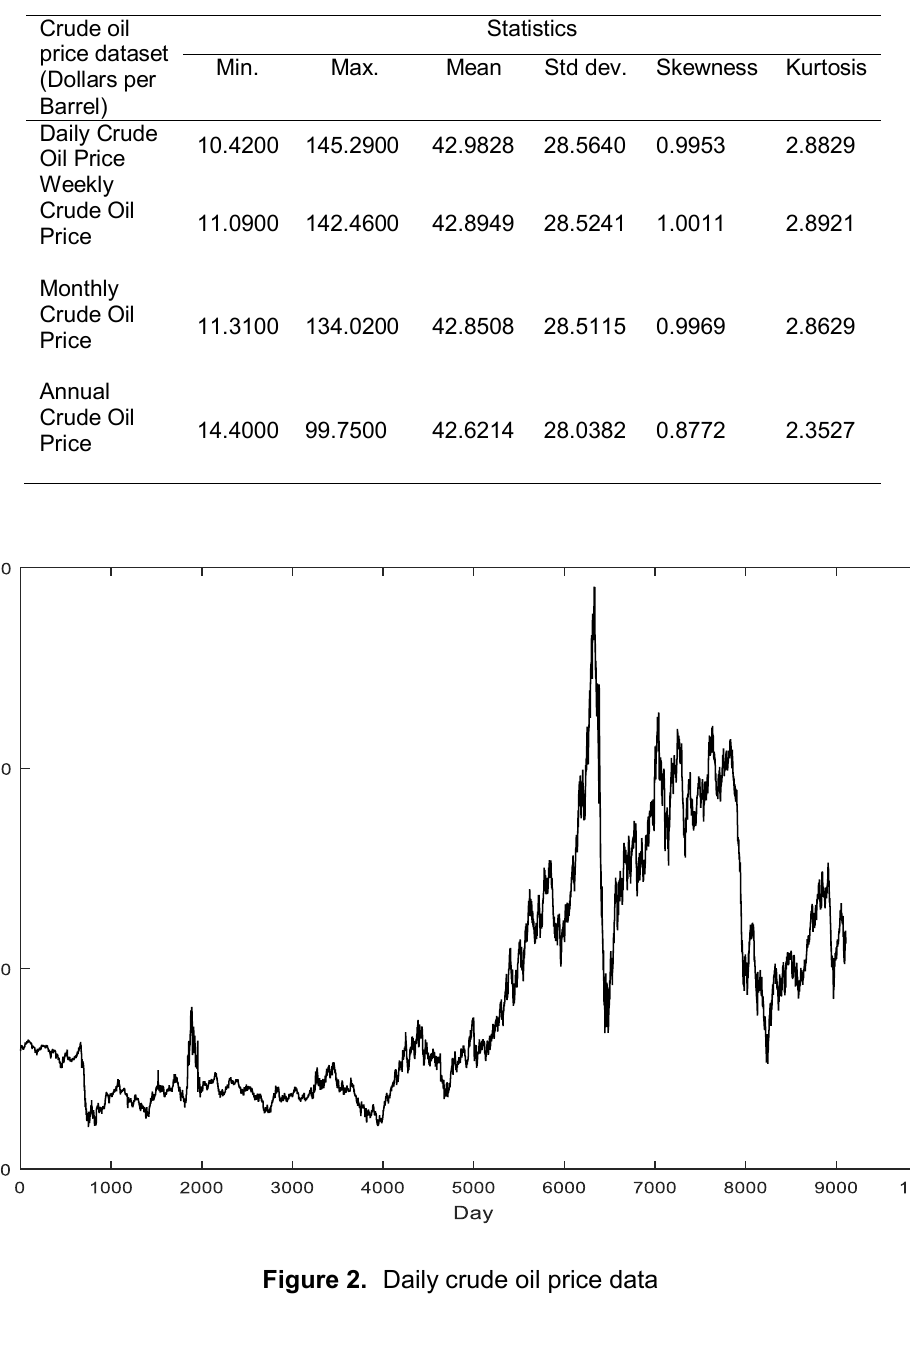
Table 2 . Descriptive statistics from crude oil price datasets